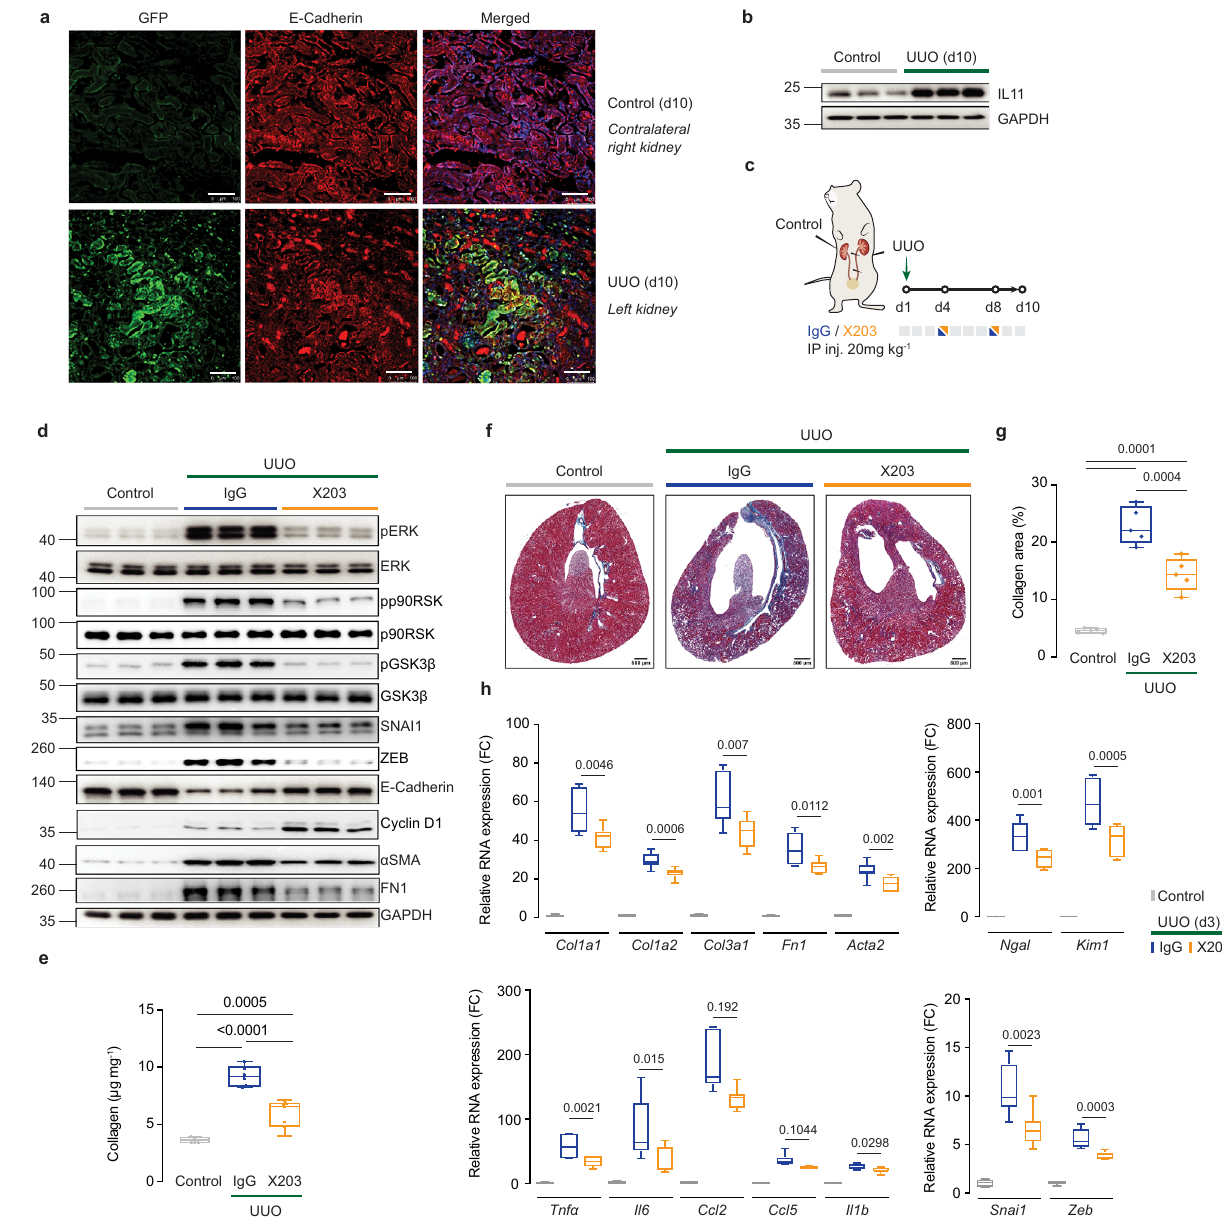
Fig. 5 | Therapeutic targeting of IL11 protects mice from UUO-induced renal tubule damage, in fl ammation, and fi brosis. a Representative immuno- fl uorescence images (scale bars: 100 µ m) of EGFP and E-Cadherin expression in UUOandcontrolkidneysof Il11 EGFP/+ mice(representativedatasetfrom n =3/group) and b Western blots of IL11 protein expression in control and UUO kidneys (representative dataset from n =5/group). Kidneys were collected at day 10 and contralateral kidneys were used as controls. c Schematic of X203 therapeutic dosing of mice subjected to left unilateral ureteral obstruction for experiments shown in ( d – h ). IgG/X203 (10mg/kg) was administered on day 4 and day 8 post UUO and kidneys were collected on day 10; contralateral (right) kidneys from the IgGgroupwereusedascontrols. d WesternblotsofpERK,ERK,pp90RSK,p90RSK, pGSK3 β , GSK3 β , SNAI1, ZEB, E-Cadherin, Cyclin D1, α SMA, FN1, and GAPDH